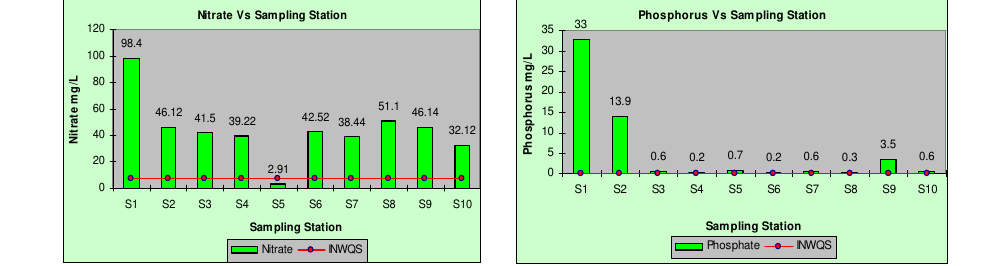
Figure 9. Nitrate vs. Sampling Station.